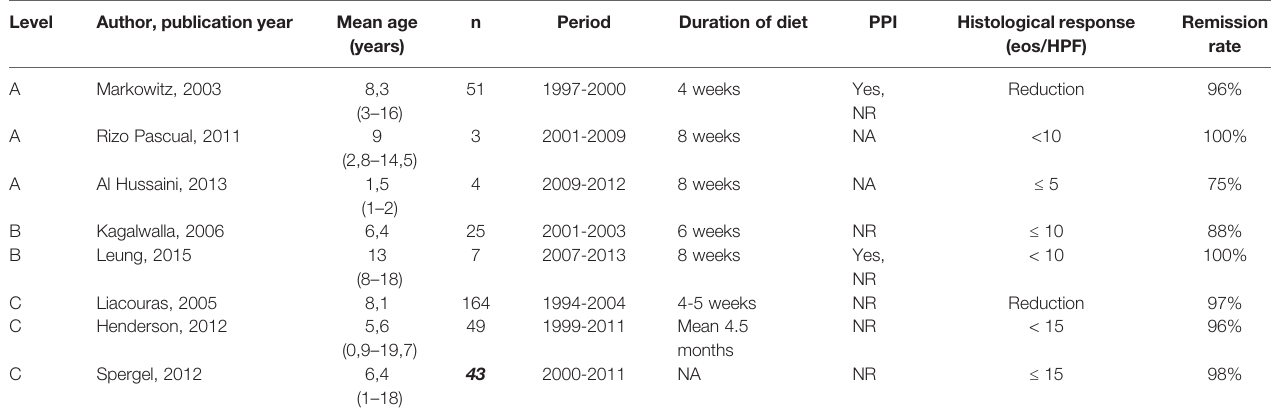
TABLE 2 | Overview of studies on the elemental